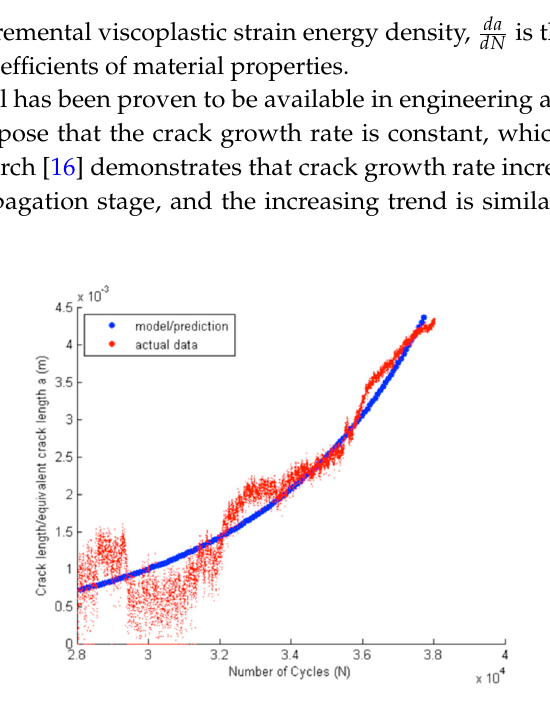
Figure 2. Relationship between the crack length and cycle number in BGA shearing test